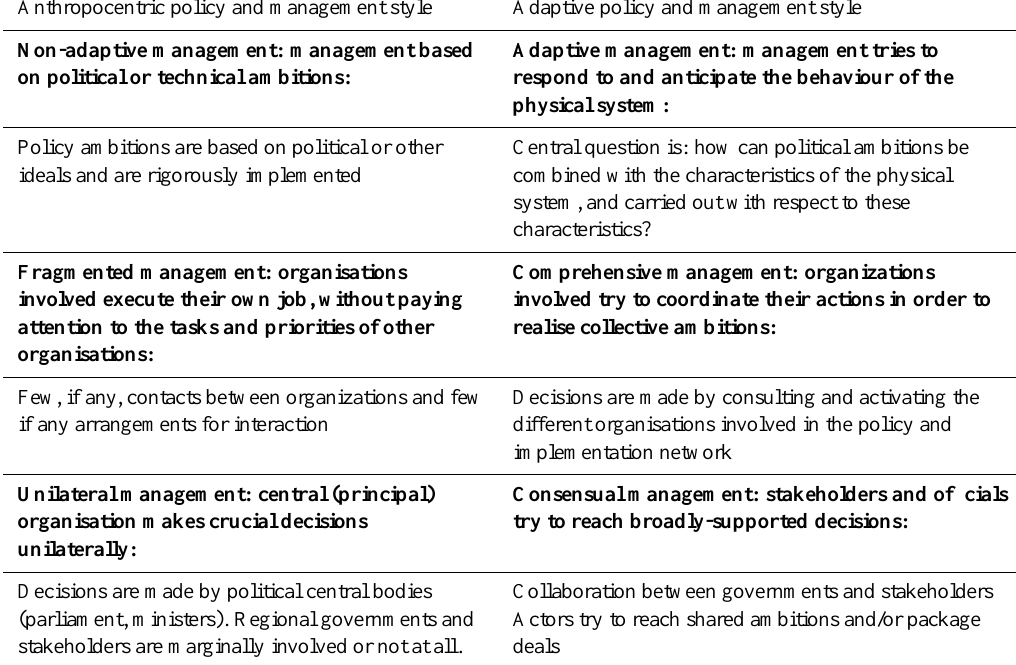
Table 3. Contrasting management styles to deal with physical